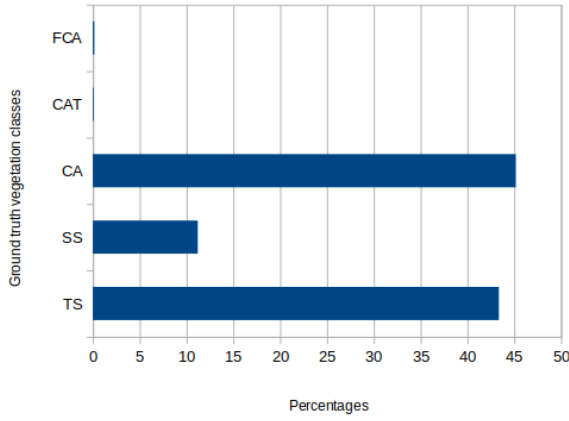
Figure 3. Percentages of vegetation classes in the reference data over the study